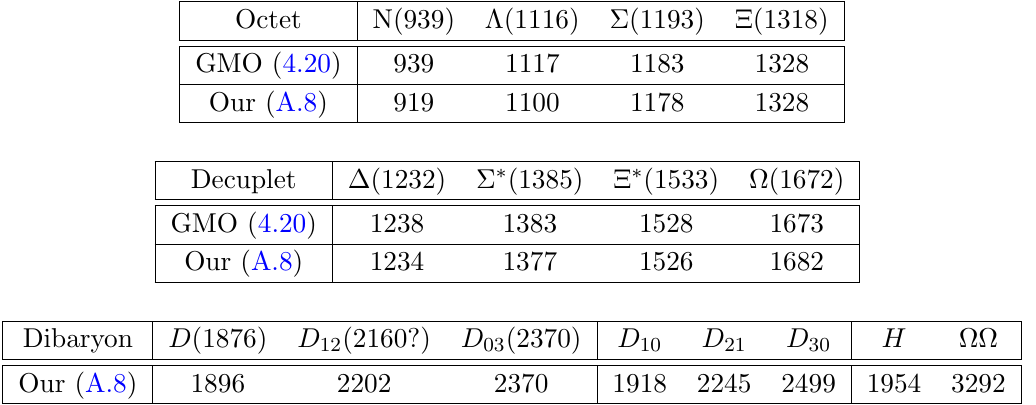
Table 11 . A numerical (cid:12)t of the hyperon and dibaryon spectrum by our formula